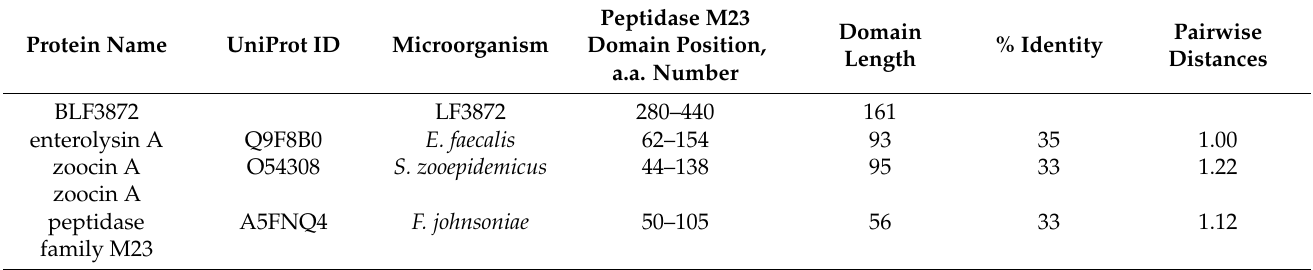
Table 1. Comparison of class III bacteriocin profile of peptidase M23 and BLF3872 bacteriocin.